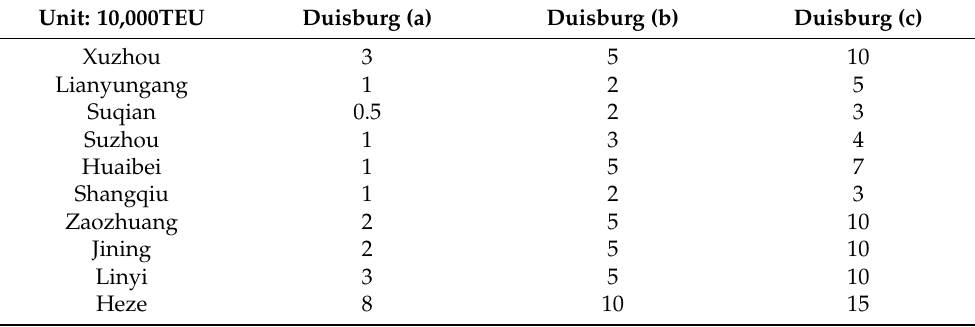
Table A7. Cross-border transportation uncertain demand between origin cities and